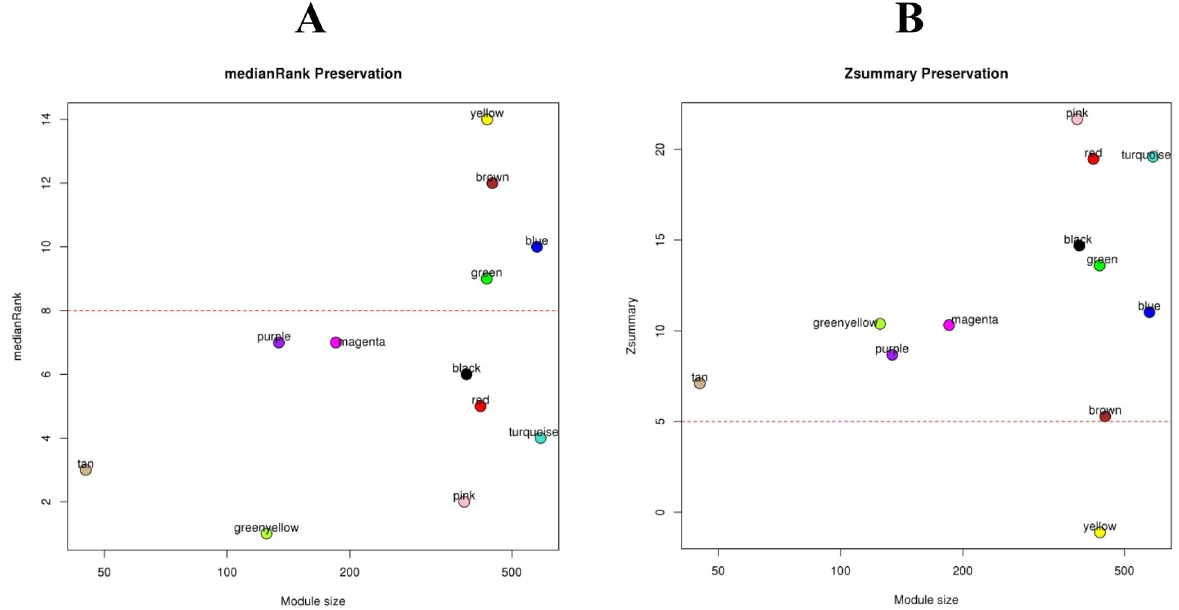
Figure 2. Conservation analysis of defined modules by using medianRank ( A ) and Zsummary ( B ) as a function of the module size. Each labeled color represents a module. The dashed red line indicates the threshold medianRank = 10 and Zsummary = 5. A module was considered as non-preserved if it had medianRank > 8 or Zsummary < 5. Figures created by the WGCNA Bioconductor